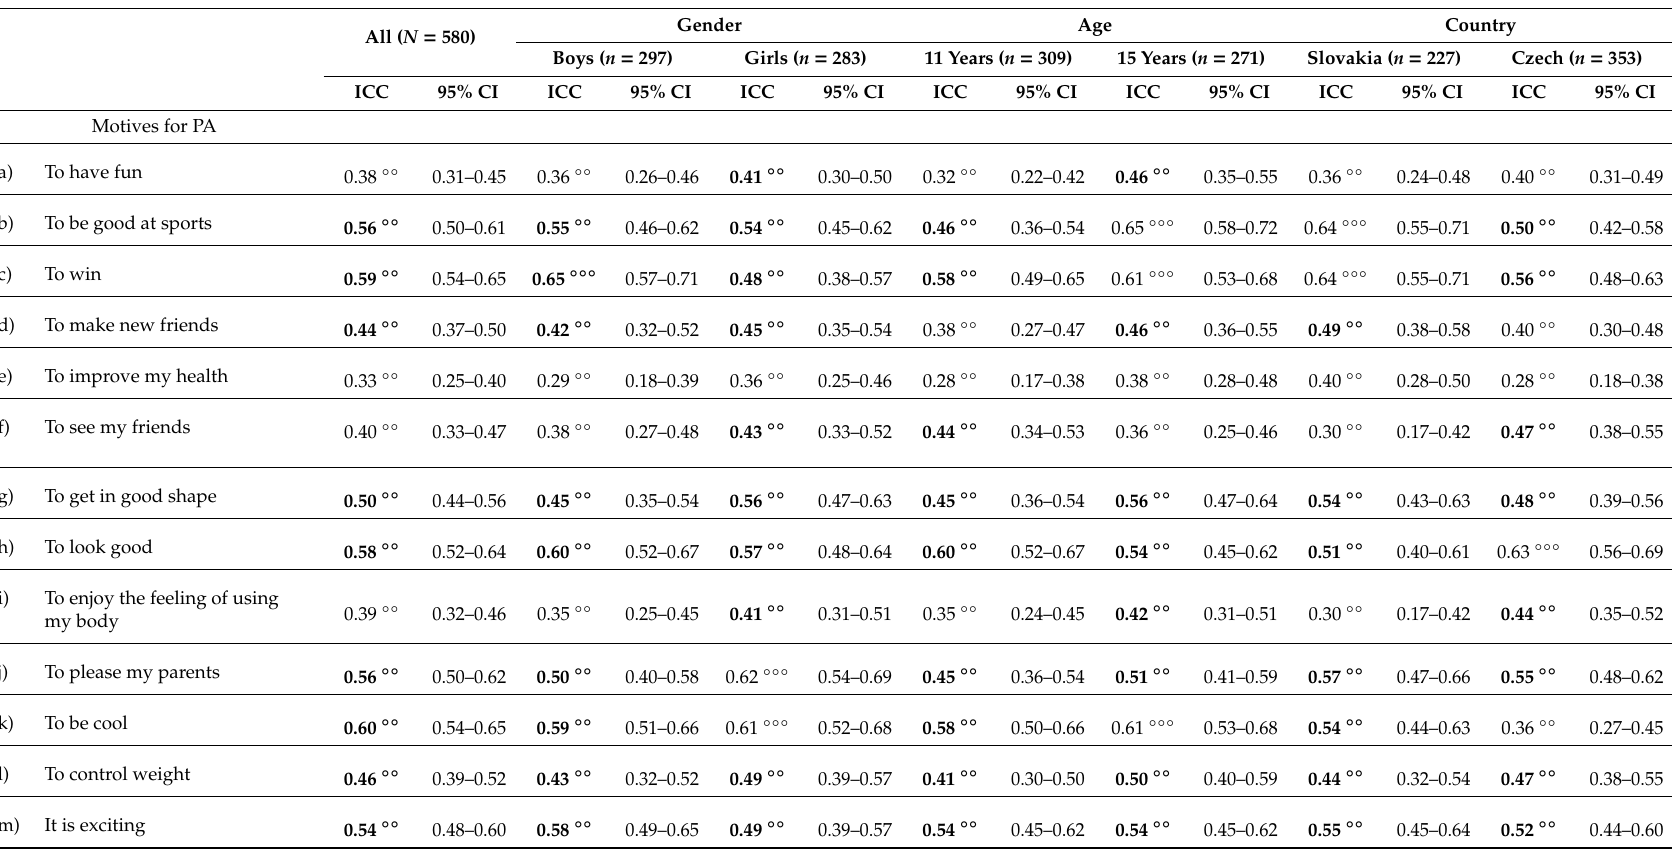
Table 2. Intraclass Correlation Coe ffi cients (ICC) for HBSC items regarding motives for physical activity by gender, age group and country (Slovakia and Czech Republic,